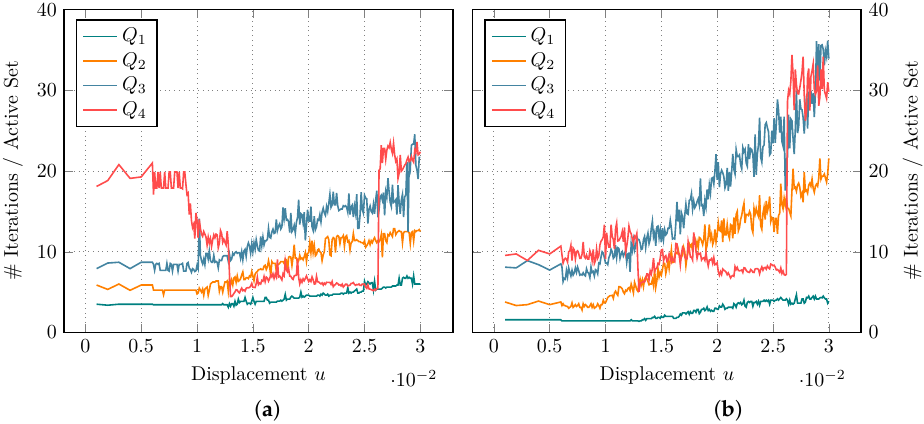
Figure 9. Iteration counts using the single-edge notched shear test. ( a ) Block-diagonal AMG and ( b ) MF-GMG preconditioner. Both strategies require more iterations once the domain is close to total failure. Mesh refinement corresponds to (cid:96) = 7, the length-scale parameter is fixed at ε = 4 × 10 − 3